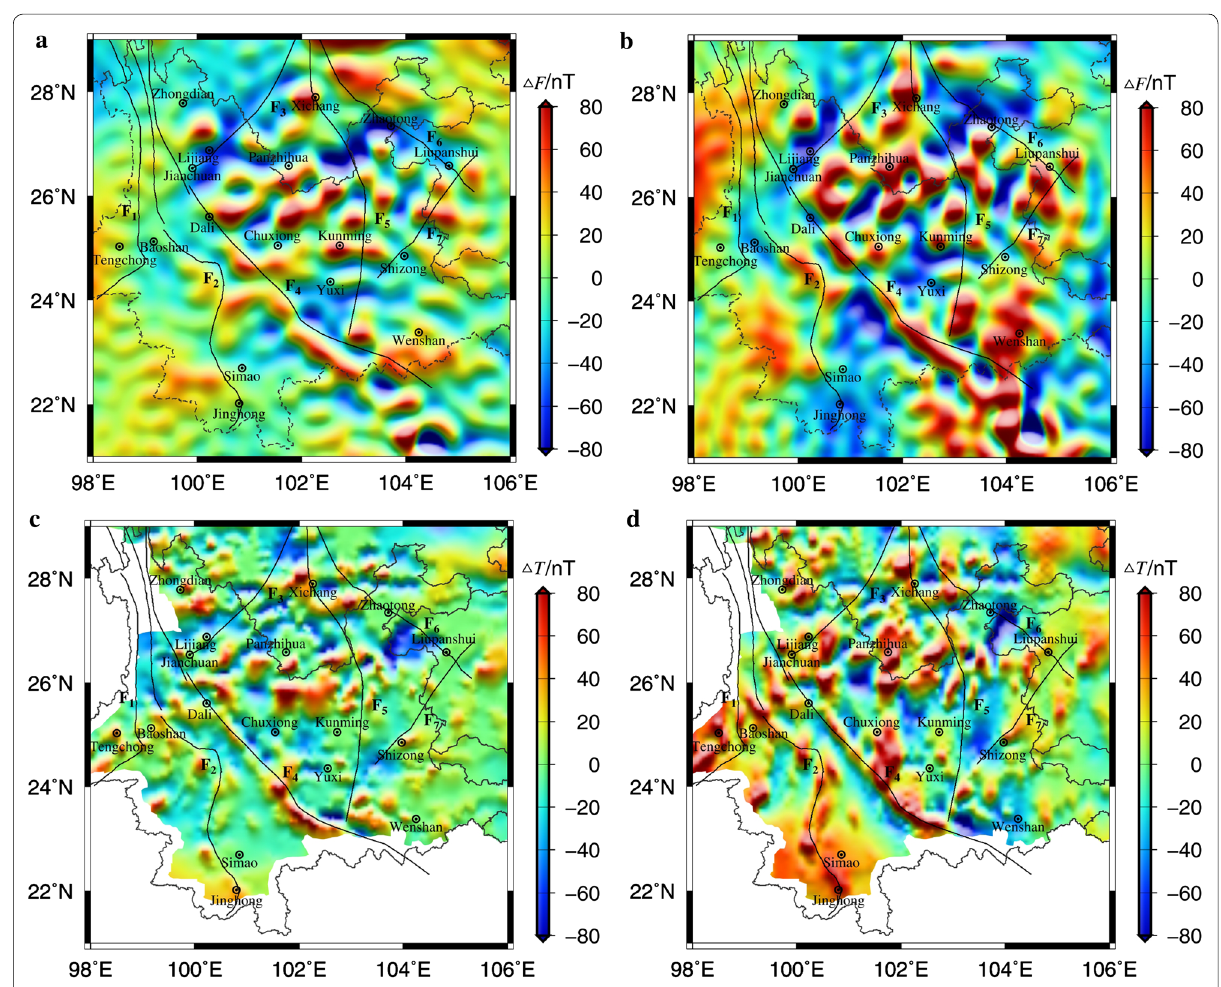
Fig. 2 Crustal magnetic anomaly of the total intensity Δ F from a NGDC-720 model, b reduction-to-pole magnetic field of Δ F , c aeromagnetic anomalies and d reduction-to-pole aeromagnetic